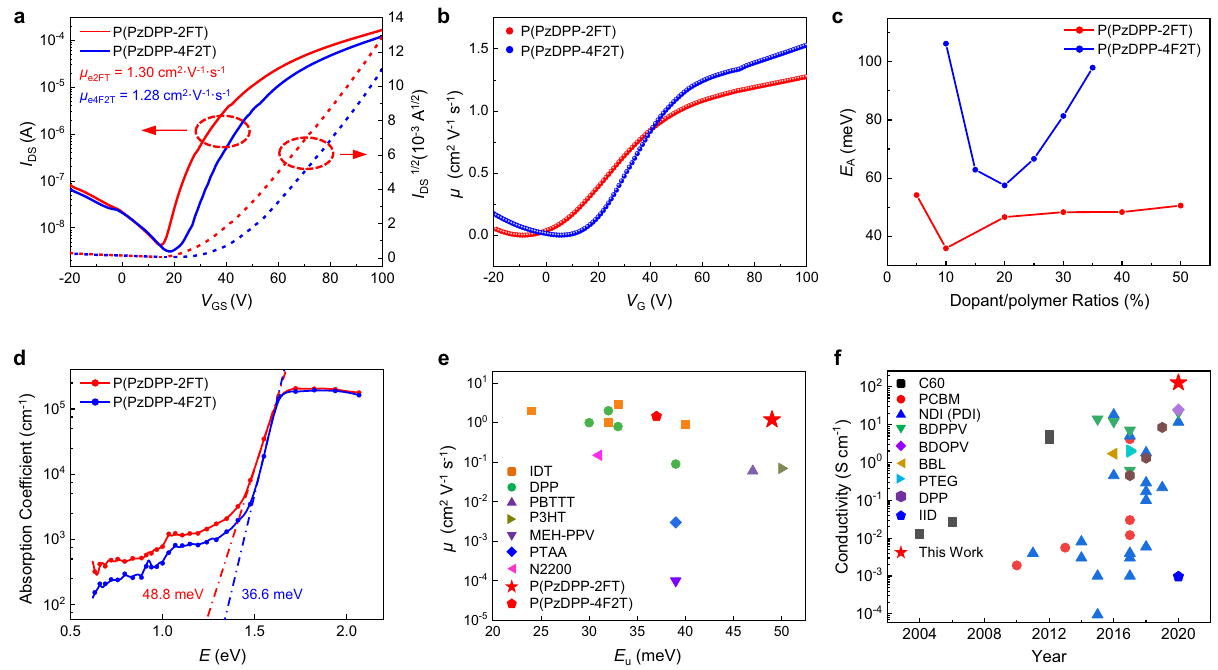
Fig. 4 Comparison of the charge-transport properties, Urbach energies, and activation energies. a Transfer characteristics of the pristine P(PzDPP-2FT) and P(PzDPP-4F2T) fi lms. b Gate-voltage-dependent saturation mobilities. c Extracted activation energies of the doped fi lms at different dopant/polymer ratios. d Absorption coef fi cients of both the pristine polymer fi lms measured by PDS. Dash lines represent exponential tail fi ts for extraction of the Urbach energies. e Mobility vs. Urbach energy of ours and other reported polymers. f Electrical conductivity comparison of reported n -doped semiconducting